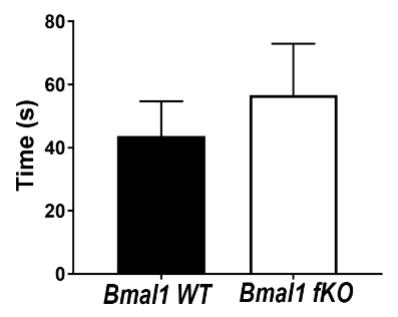
Figure 9. Olfactory function is not affected in Bmal1 fKO mice. The latency to find the hidden food was comparable in Bmal1 WT and Bmal1 fKO . n = 14 mice per genotype.